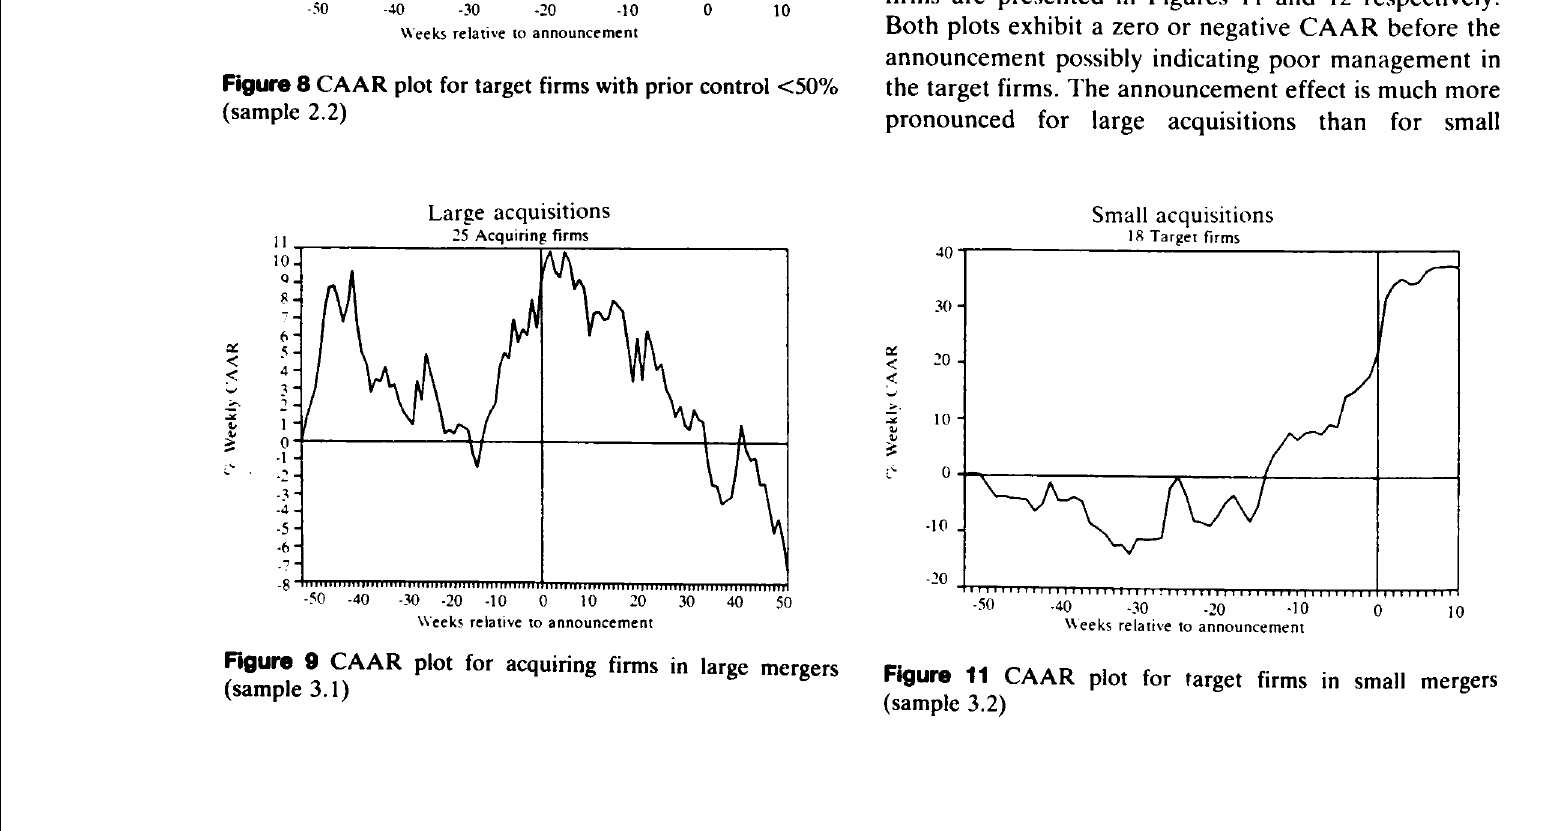
Figure 8 CAAR plot for target firms with prior control <50% (sample 2.2)